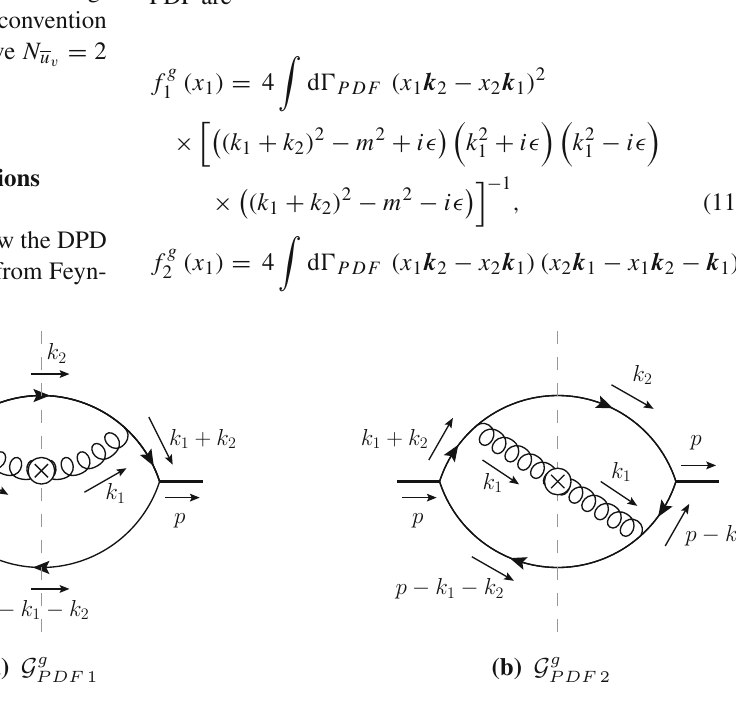
Fig. 1 Two graphs contributing to the gluon PDF at order O (α s ) in our model. Two more graphs are obtained by reversing the arrows that indicate the flow of quark